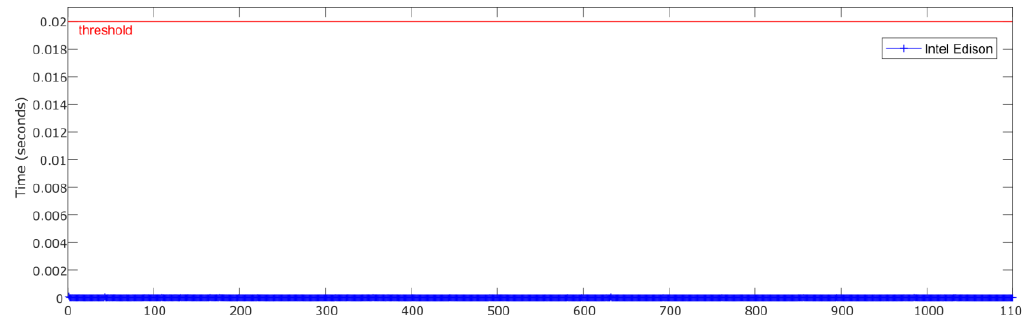
Figure 12. Test 2. Processing time of each iteration for Intel Edison. Table 6. Test 2. Processing time on Raspberry Pi 3 Model B and Intel Edison.